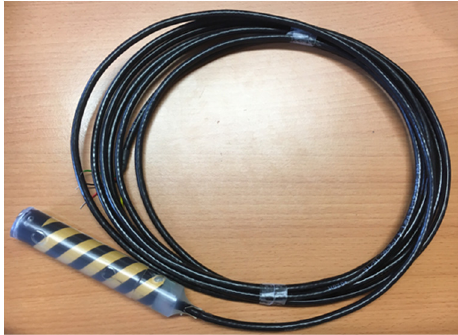
Figure 29. Industrially molded sensor.